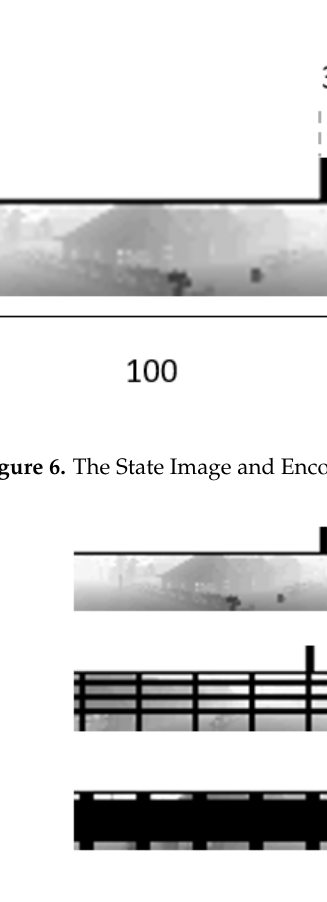
Figure 7. Fences drawn on the State